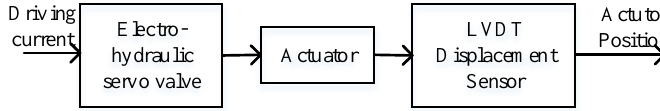
Figure 11. Fuel metering model diagram.